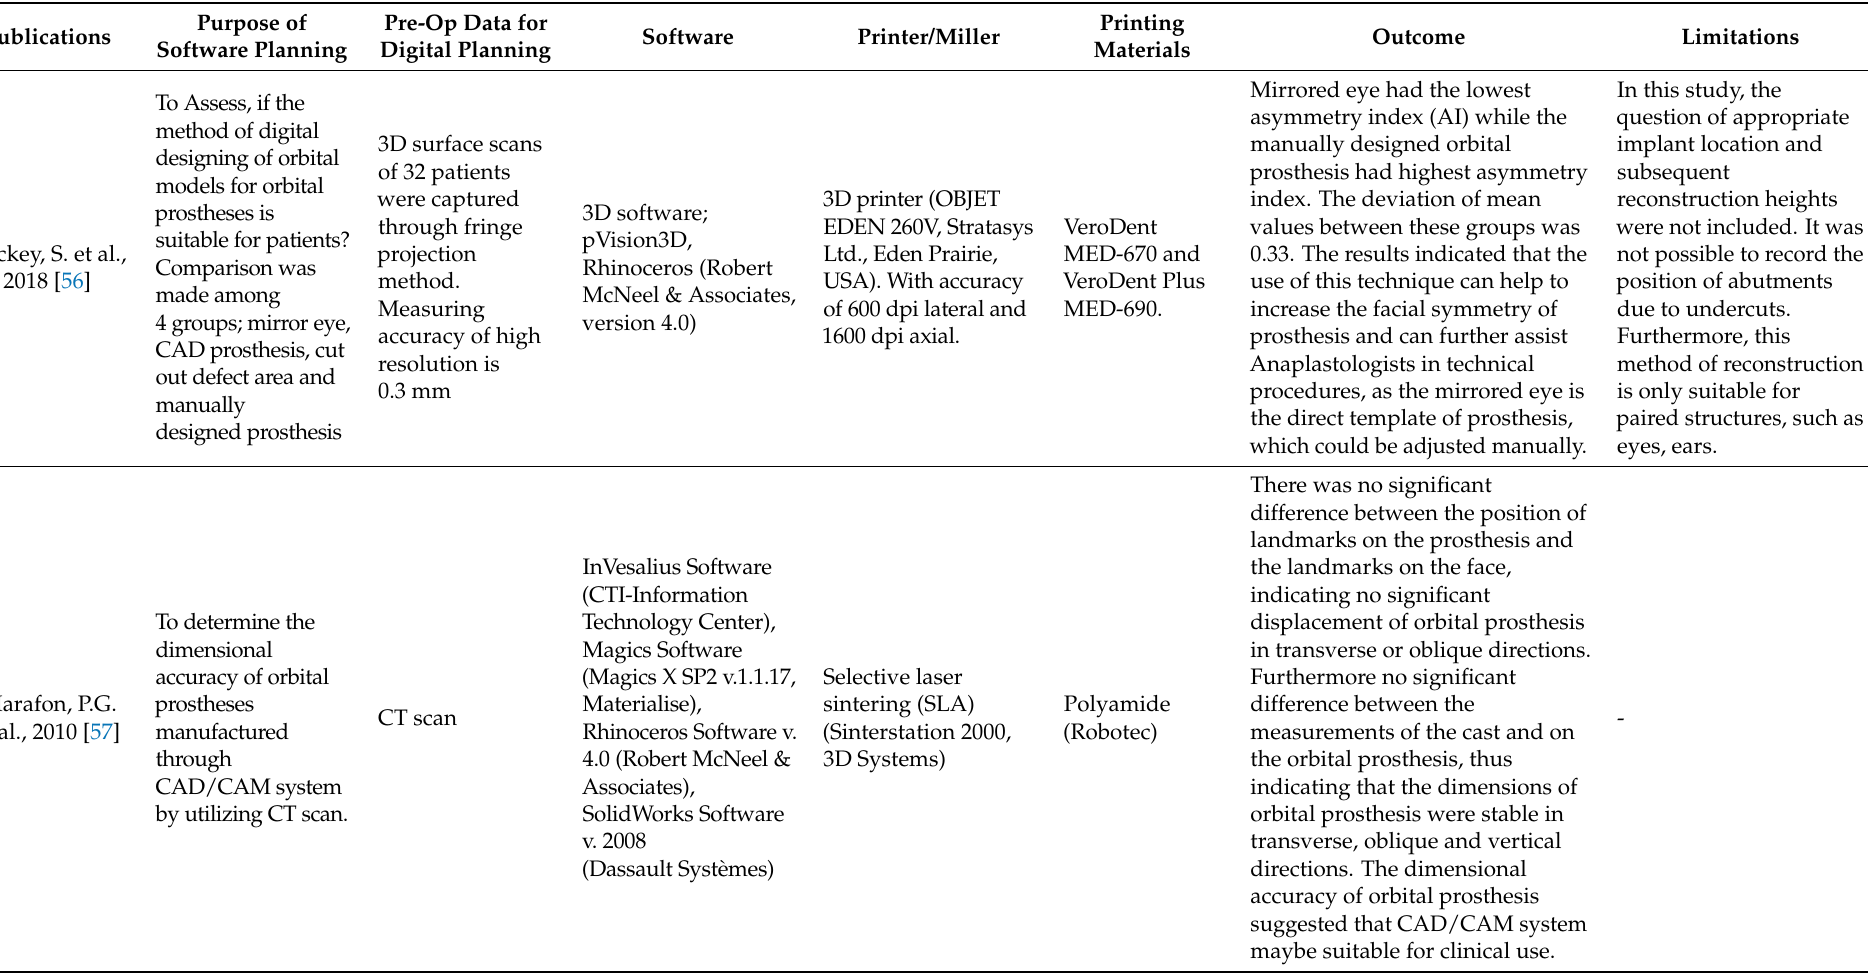
Table 7. Nonclinical studies that assessed the accuracies of digital systems for orbital implants placement and the fabrication of orbital